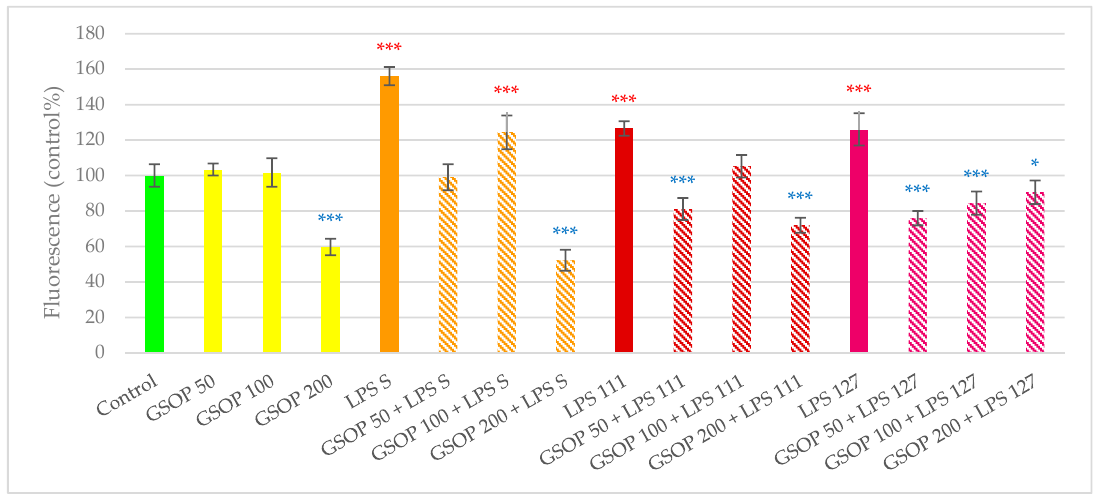
Figure 3. Amount of intracellular reactive oxygen species after treatment with bacterial endotoxin (LPS), purified grape seed oligomeric proanthocyanidins (GSOPs) and their combinations. Control— plain cell culture medium treatment; GSOP 50: 50 μ g/mL GSOP; GSOP 100: 100 μ g/mL GSOP; GSOP